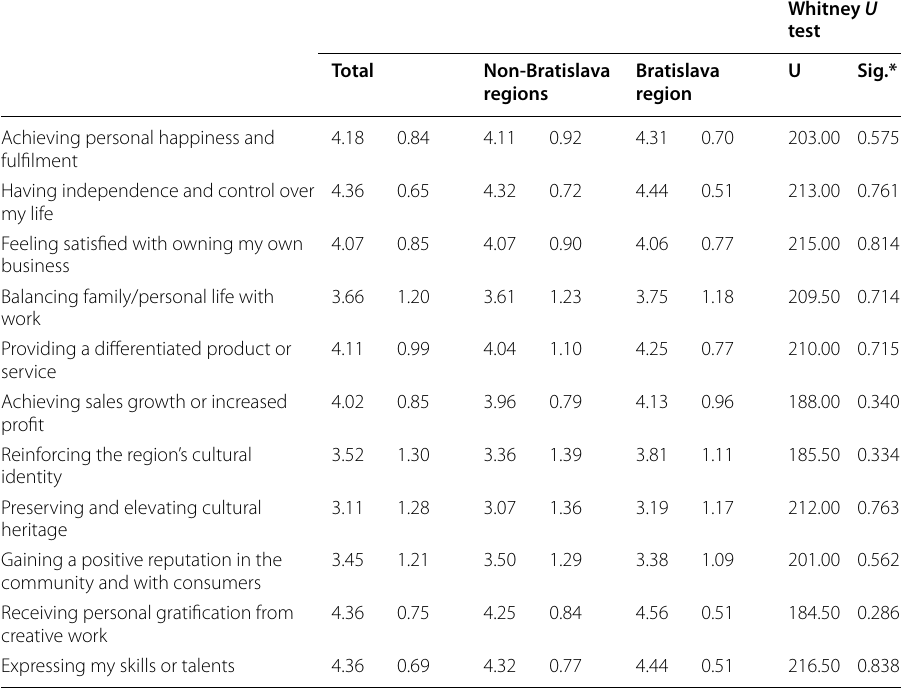
Table 2 Perceived success in specific